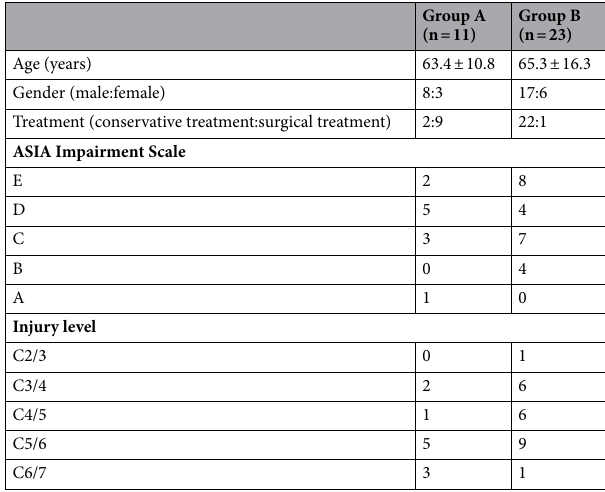
Table1. Patient demographics. Values are mean ± standard deviation.